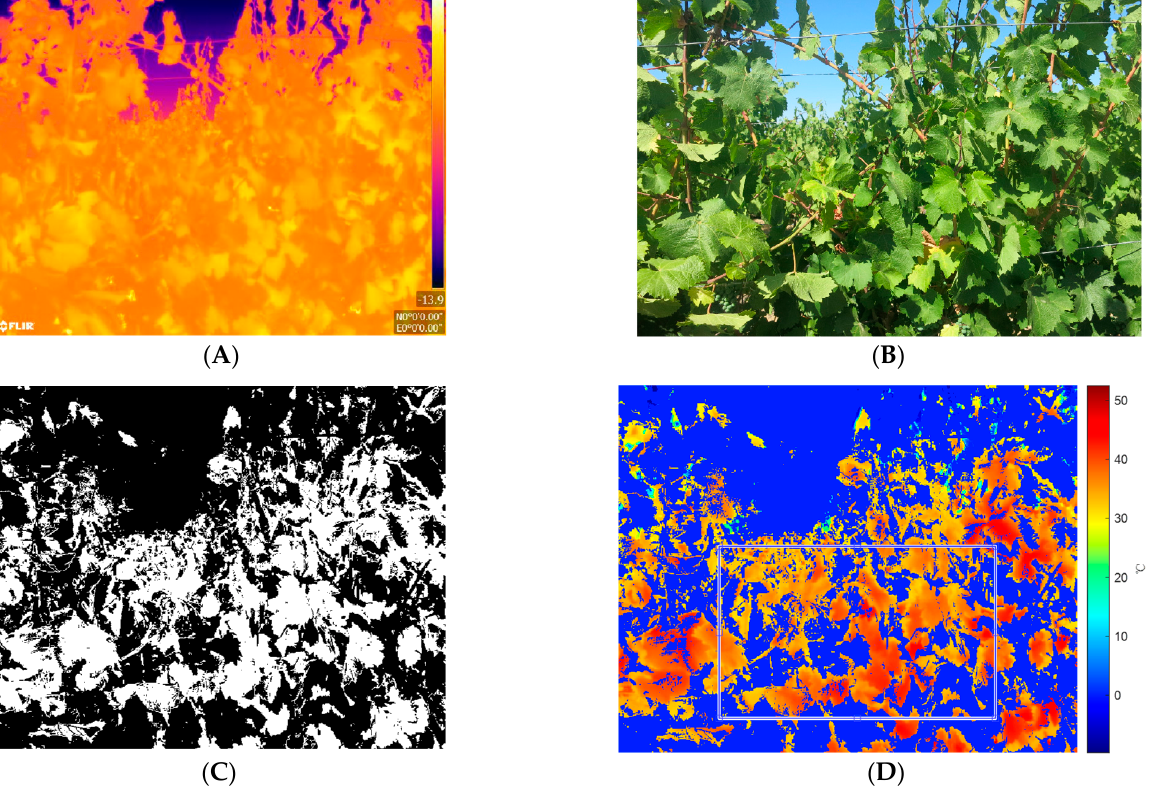
Figure 3. Thermal imagery and processed image of a sample grapevine canopy: ( A ) false color ther- mal image, ( B ) original RGB image, ( C ) canopy binary mask, ( D ) overlapped thermal image with selected rectangle ROI.